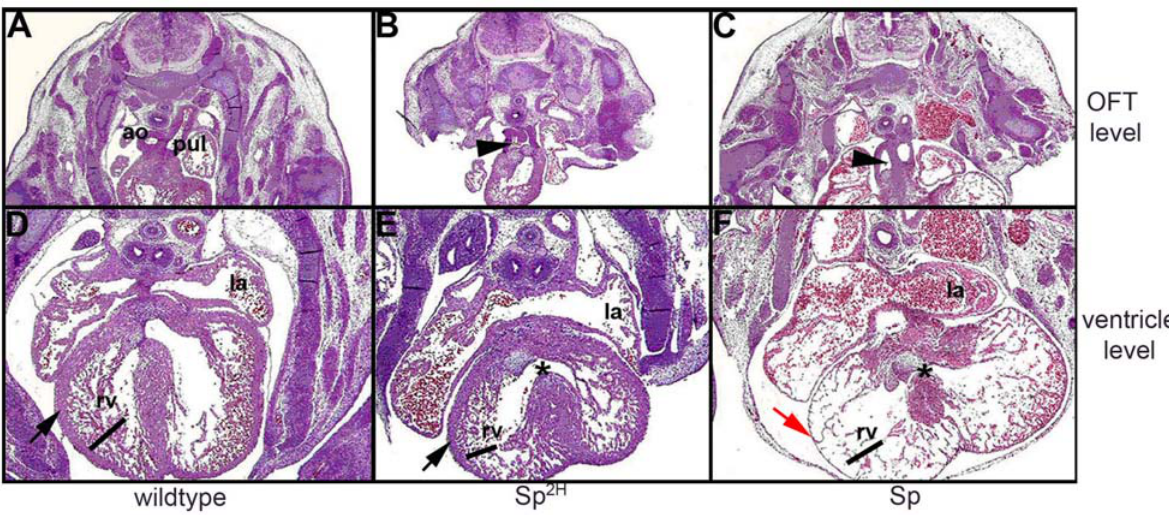
FIGURE 3. Histological analysis of the E13.5 ventricular myocardium in wild-type and pax3 allelic mouse mutants. (A and D) Wild-type, (B and E) sp 2H , and (C and F) sp embryonic hearts transversely sectioned. Note that both the sp 2H and sp homozygous mutants have OFT defects (arrowheads) and VSDs (indicated by *), but that only the sp myocardium is abnormally thin. Trabeculation (indicated by bar in right ventricles; rv) is still present in sp mutants (although sparse), but the highly proliferative sp compact layer (indicated by red arrow) is severely diminished when compared to sp 2H and wild-type littermates (arrows in D and E). Abbreviations: ao, aorta; pul, pulmonary artery.